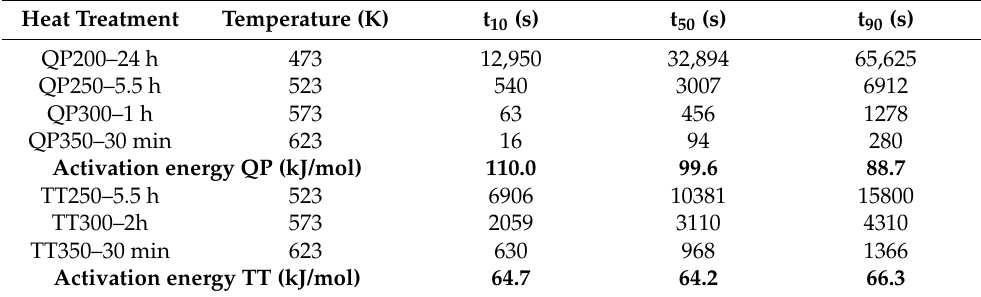
Table 4. Data used for calculating overall activation energy of bainite transformation in different transformation